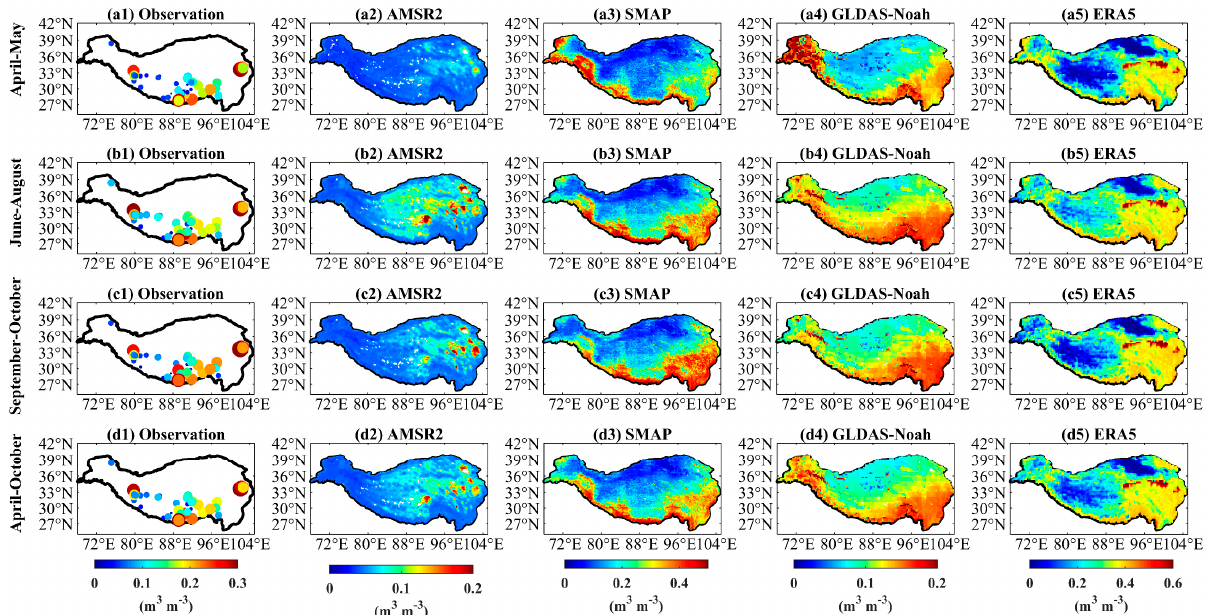
Figure 4. The spatial distributions of in situ observed, AMSR2, SMAP, GLDAS-Noah, and ERA5 SM in April–October during 2015–2016 in the TP. The size of the circles represents the SM absolute value at each observation site.